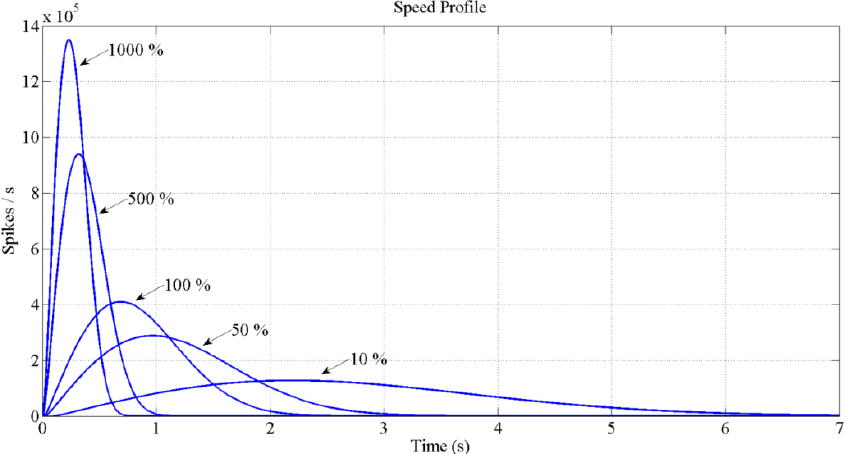
Figure 14. Speed profiles achieved by modifying slope_counter parameter of GO block. velocity is reached later for faster movements if entire length is